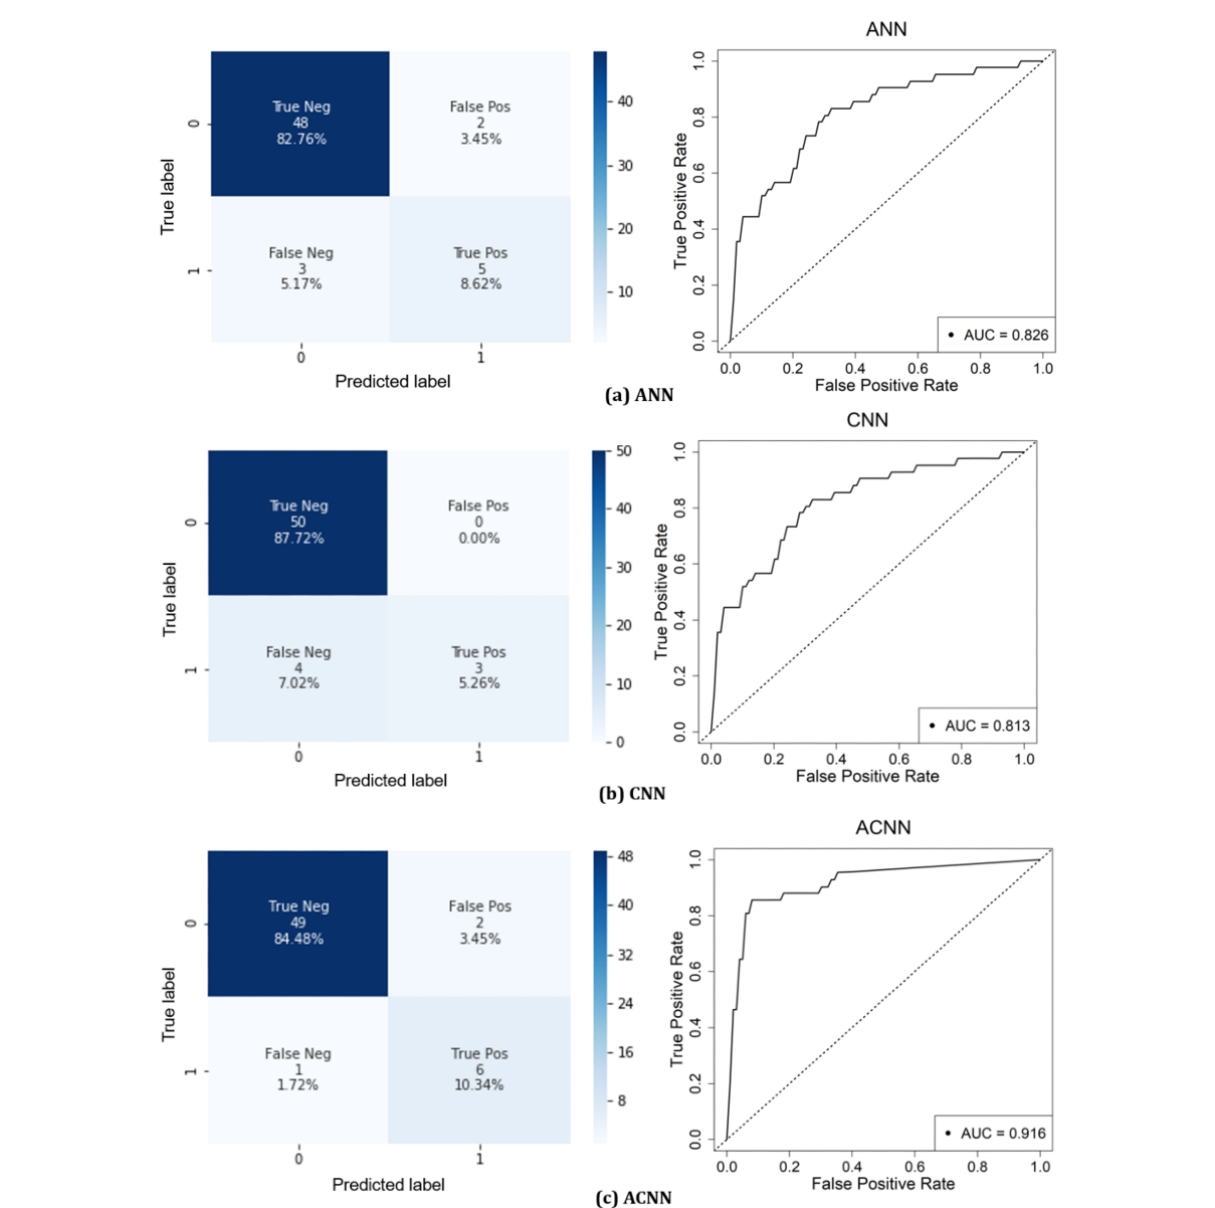
Figure 4. Receiver operating characteristic (ROC) curves and confusion matrices (with a threshold of 0.5) of (a) artificial neural network (ANN), (b) convolutional neural network (CNN), and (c) artificial convolutional neural network (ACNN) models for event and event-free novel coronavirus pneumonia (NCP) lesion data sets. AUC: area under the curve; Neg: negative; Pos: